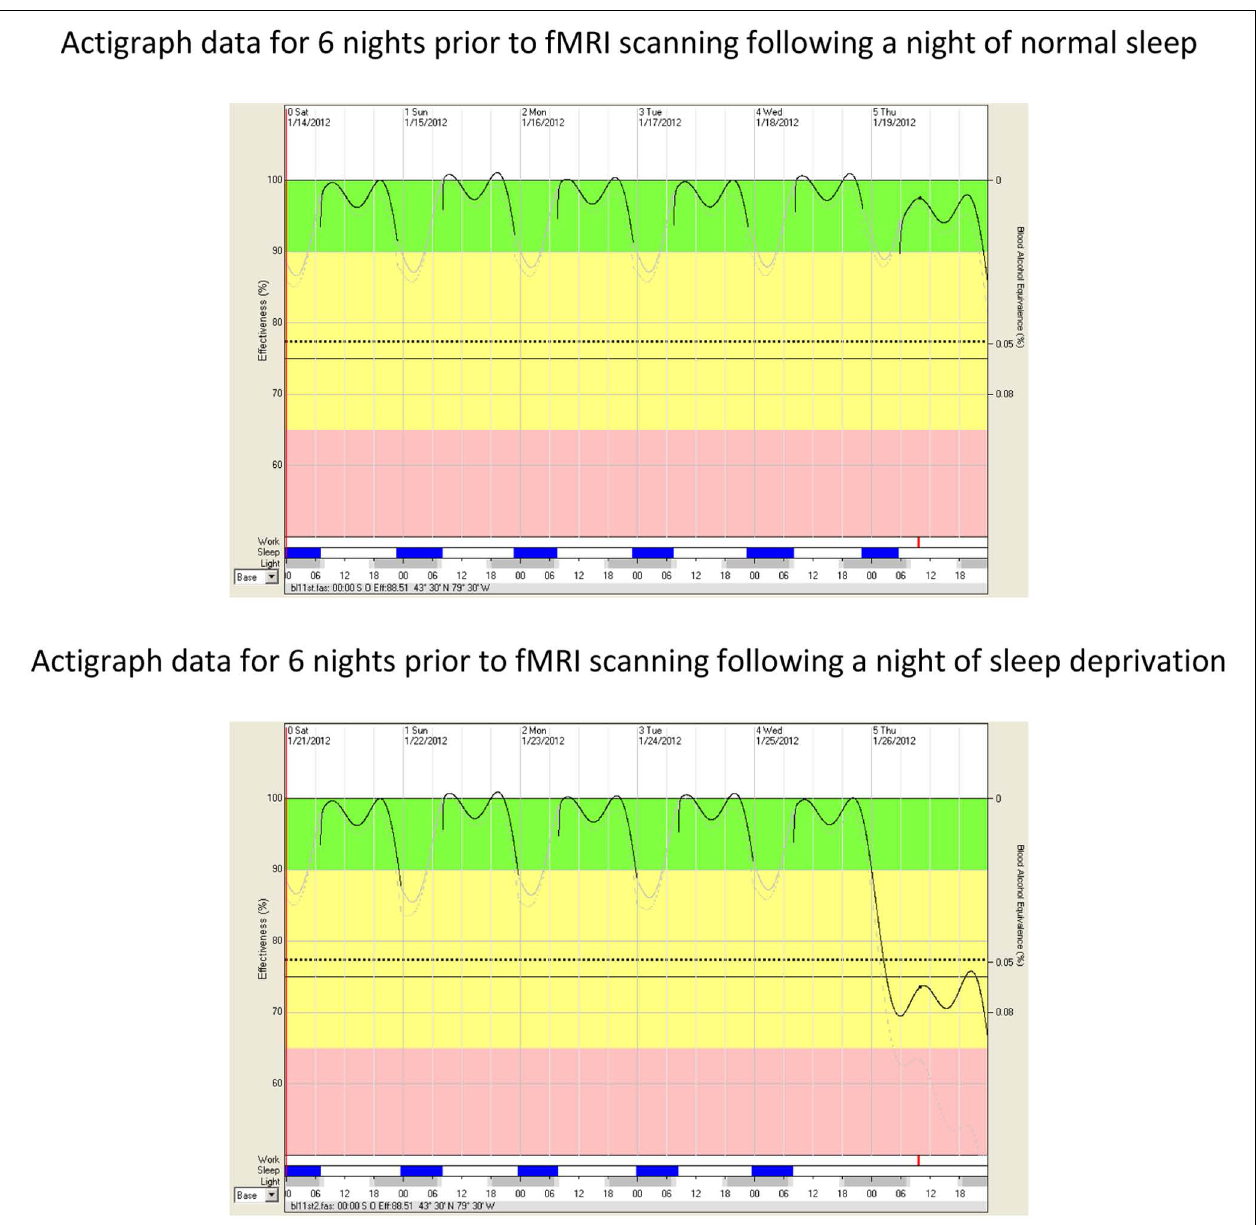
FIGURE 1 | Impairment in modeled cognitive effectiveness as a function of sleep deprivation. The vertical axis on the left side of the FAST TM graphs represents fitted and transformed modeled cognitive effectiveness as a percentage of optimal performance (100%).The oscillating line in the diagram represents average modeled cognitive effectiveness as determined by time of day, biological rhythms, time spent awake, and amount of sleep.The vertical axis on the right side of FAST TM graphs represents the Blood Alcohol Content (BAC) equivalency throughout the spectrum of modeled cognitive effectiveness. A value of 77% modeled cognitive effectiveness corresponds to a blood alcohol content of 0.05% (legally impaired in some jurisdictions). A value of 70% modeled cognitive effectiveness corresponds to a blood alcohol content of 0.08% (legally impaired in most jurisdictions).The dotted line represents the lower 10th percentile of modeled cognitive effectiveness.The green band (from 90 to 100%) represents acceptable modeled cognitive